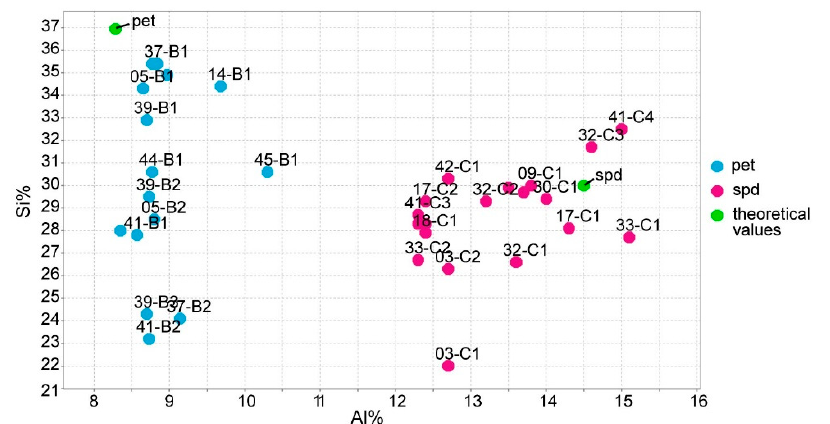
Figure 15. ICP-MS analysis of Si using Al for all the spodumene and petalite samples used on the calibrations of the portable laser-induced breakdown spectroscopy (pLIBS).